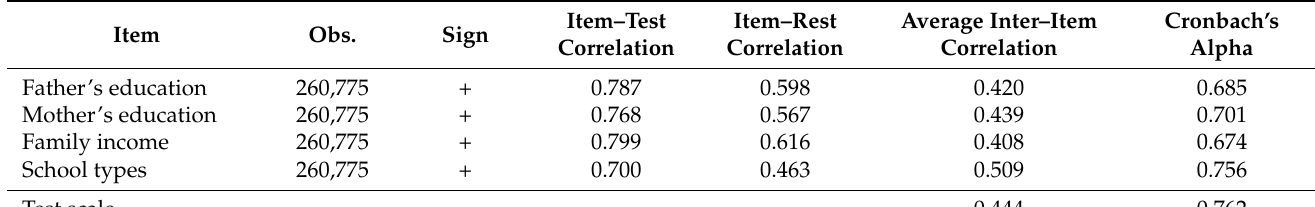
Table A2. Cronbach’s alpha of social capital